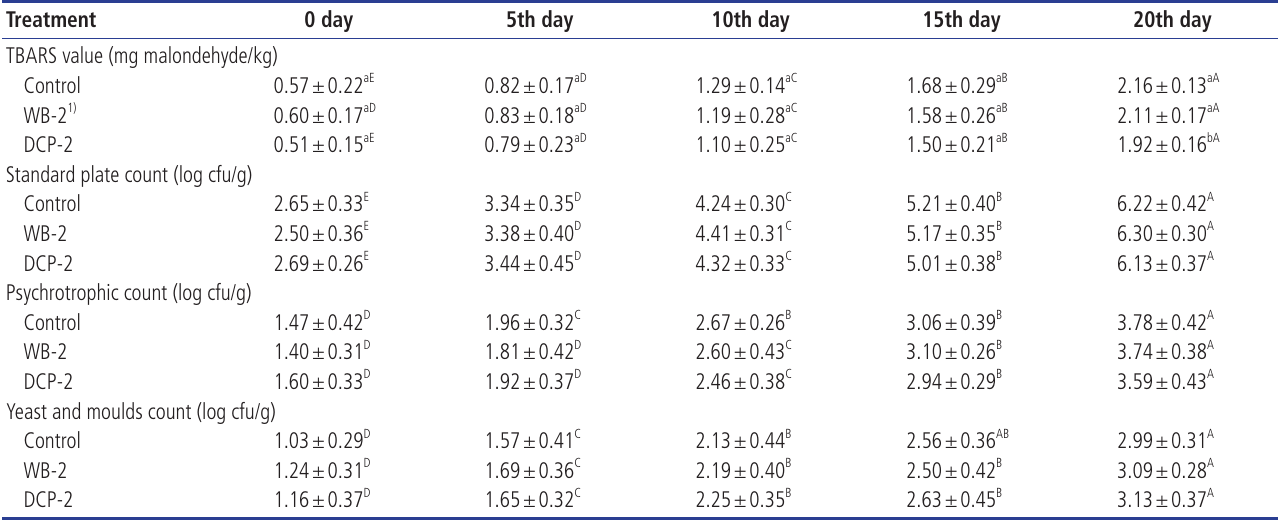
Table 5. TBARS value (mg malondehyde/kg) and microbiological quality of wheat bran, dried carrot pomace incorporated chicken sausages stored at 4°C±1°C Treatment